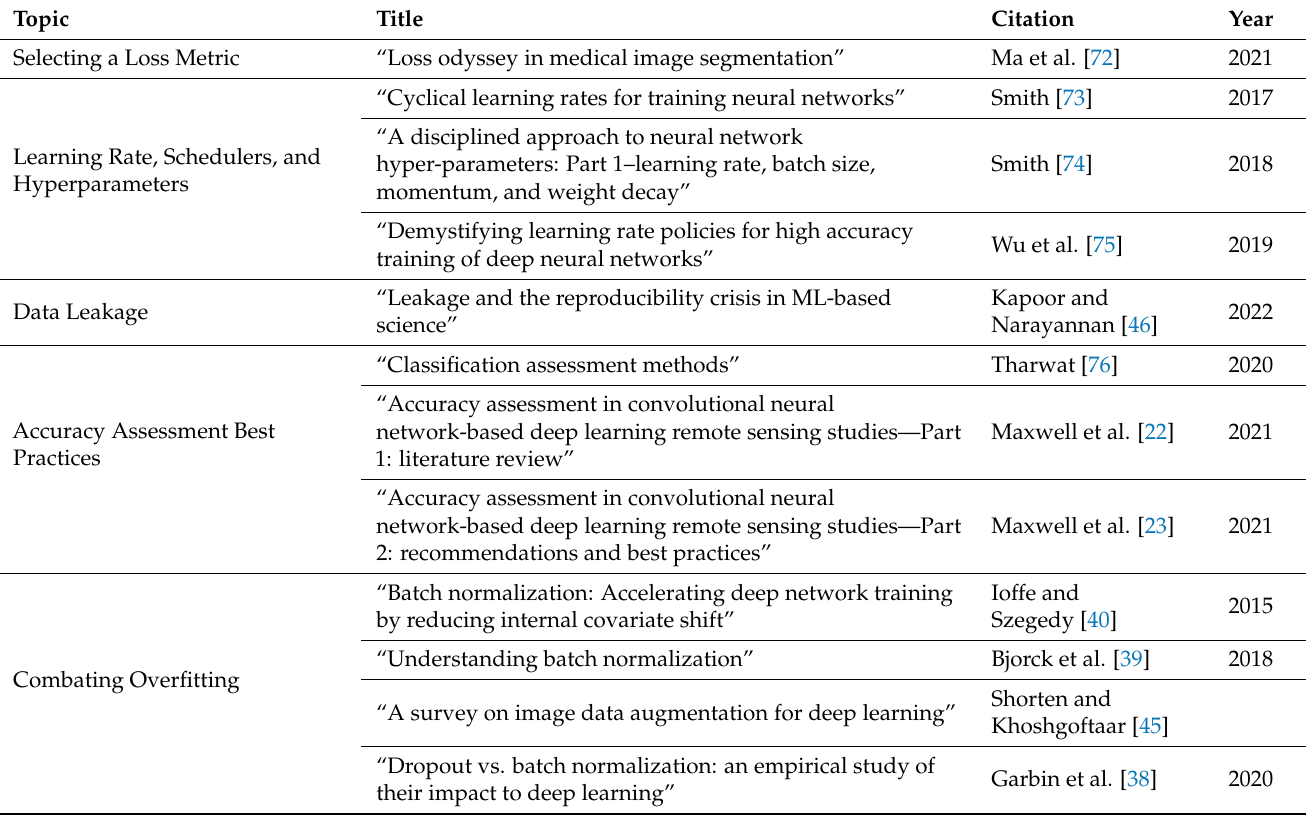
Table 1. Example studies that provide specific, technical recommendations relating to training algorithms, assessing models, and combating